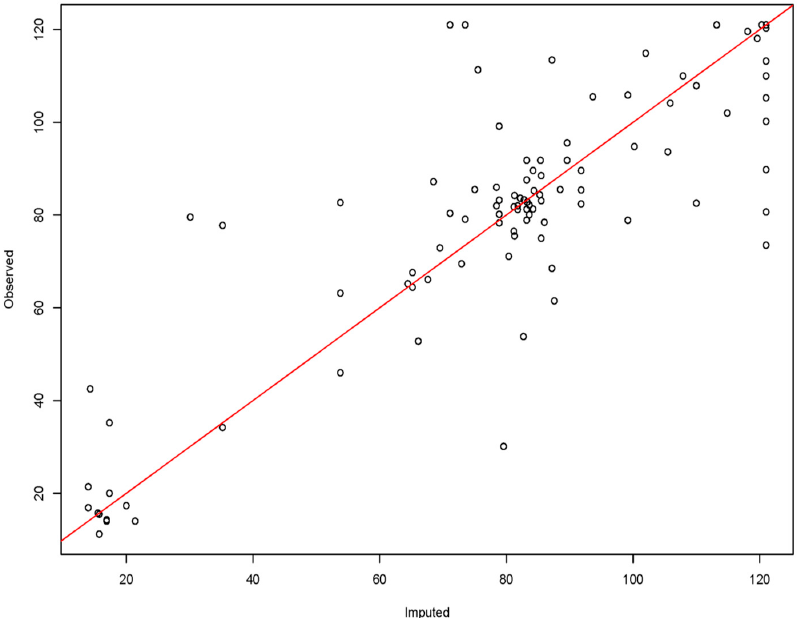
Figure 6. Scatterplot of imputed vs. observed plot age for 116 black spruce-dominated plots in the Hearst Forest of Northeastern Ontario. Red line indicates a 1:1 ratio.